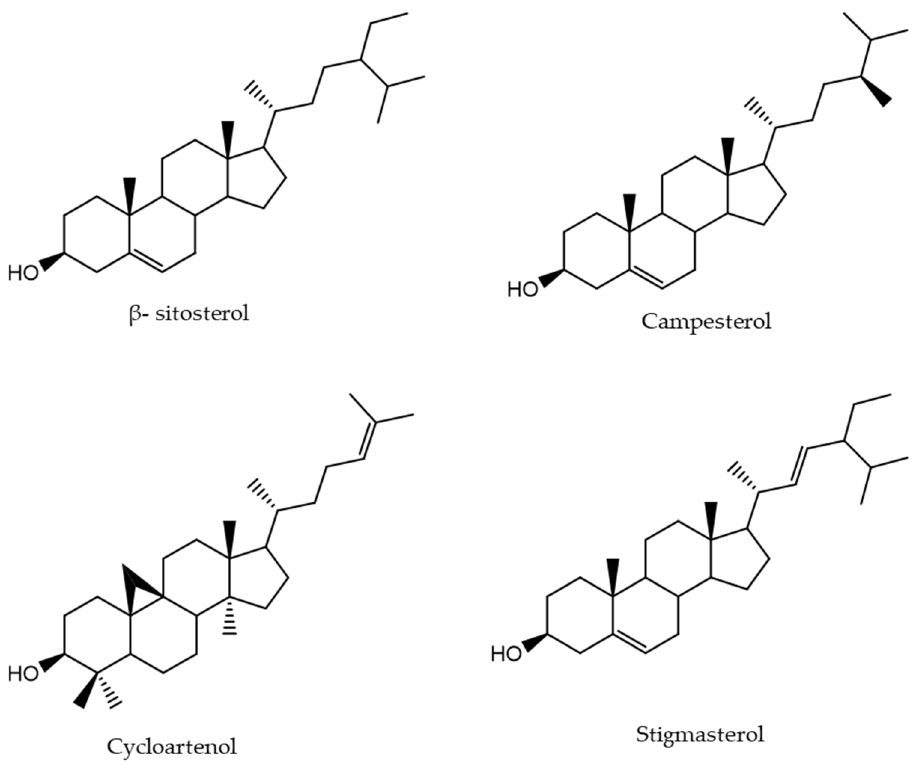
Figure 5. Chemical structures of detected phytosterols in espresso coffee. Table 2. Concentration (mg/L) of phytosterols in different espresso coffee samples. Data are expressed as mean ± standard deviation, ( n = 3 technical replicates). Total levels with different upper-case letters are statistically different with α of